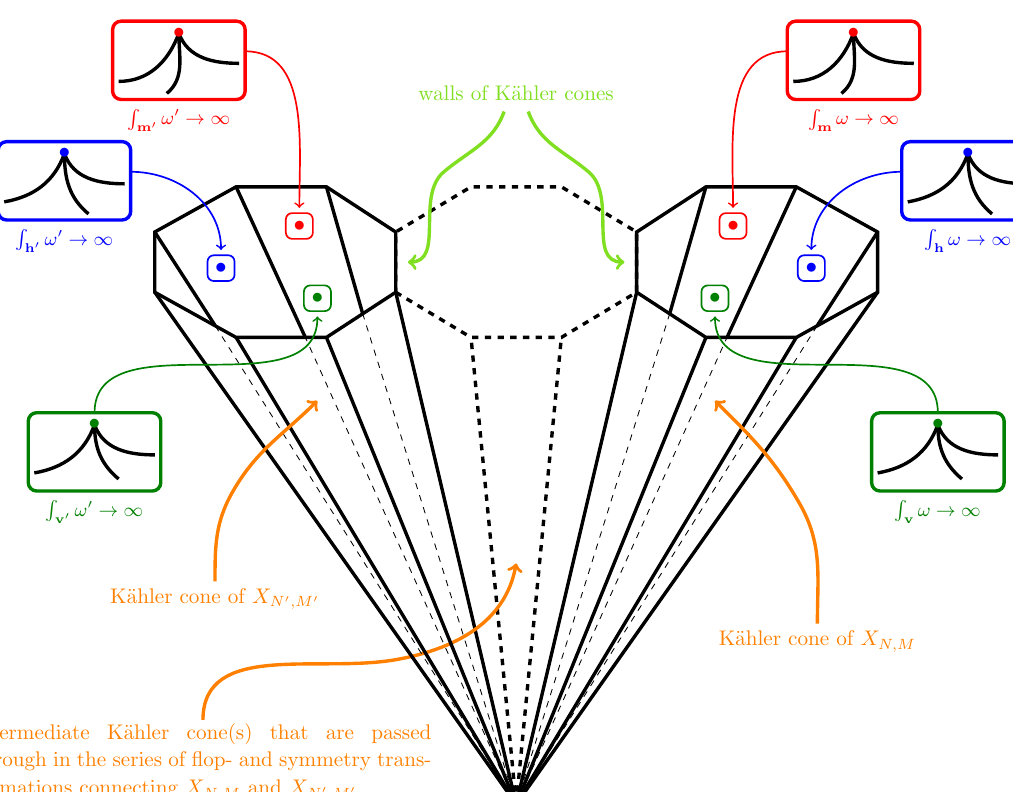
Figure 3 . Weak coupling regions in the extended moduli space of X N;M